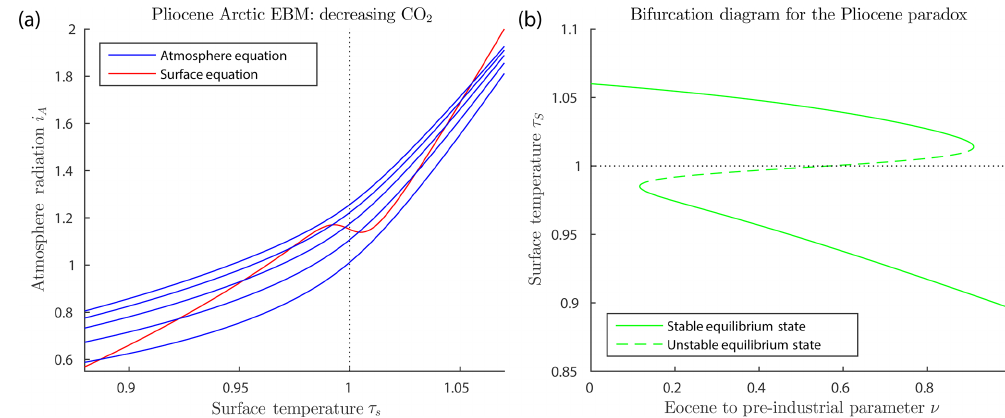
Figure 4. Pliocene Arctic EBM Eqs. (9)–(10). Parameter values δ = 0 . 67, F A = 45Wm − 2 , Q = 173 . 2Wm − 2 , α W = 0 . 08 and Z = 9km. (a) CO 2 takes values µ = 200, 500, 800, 1100 and 1400ppm from bottom to top on the blue curves with fixed F O = 50Wm − 2 on the red curve. The warm equilibrium state τ S > 1 disappears as µ decreases on successively lower blue curves. (b) Bifurcation diagram for the Pliocene paradox. Here, CO 2 concentration µ and ocean heat transport F O decrease simultaneously with increasing ν , (0 ≤ ν ≤ 1), as given by Eq. (37). As ν increases, the warm equilibrium solution ( τ S > 1) disappears in a saddle-node bifurcation at approximately ν = 0 . 91, corresponding to forcing parameters µ = 336ppm and F O = 50 . 9. The equilibrium temperatures at this value of ν are 3.9 and − 26 ◦ C, and geological time about 4.5Ma. To the right of this point, only the frozen equilibrium state exists. Between about ν = 0 . 12 and ν = 0 . 91, the frozen and warm equilibrium states coexist, separated by the unstable intermediate